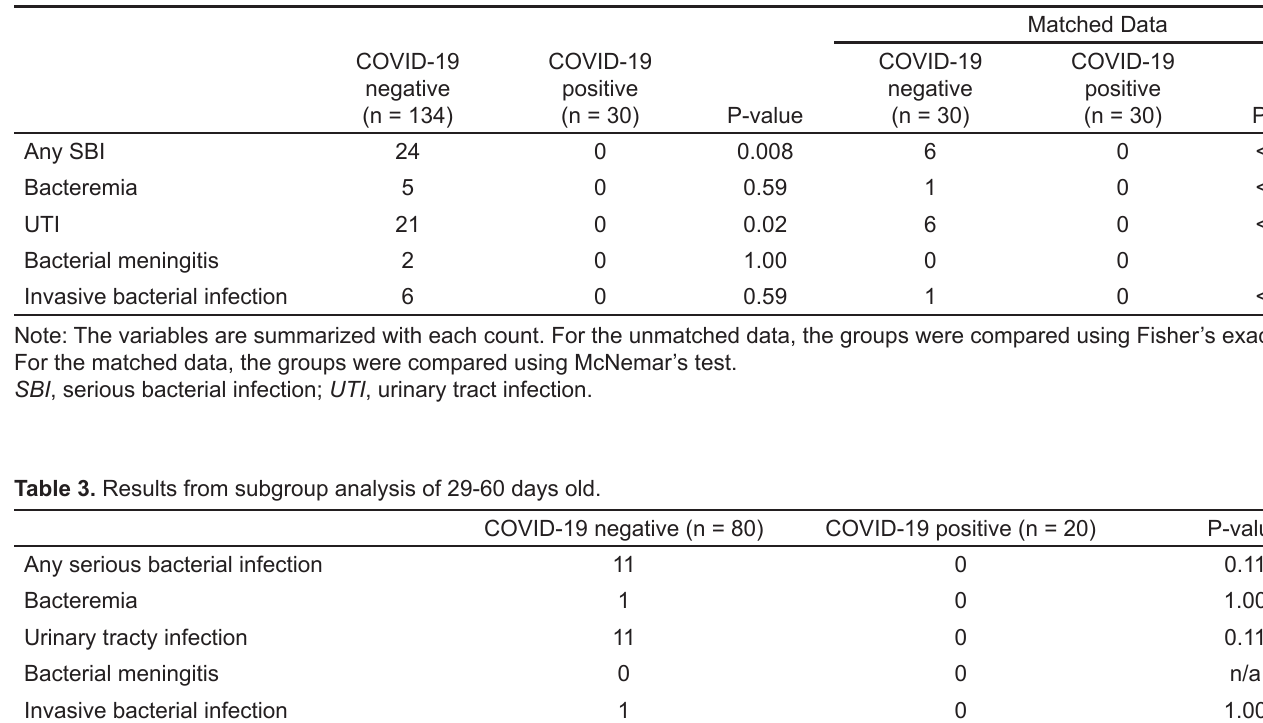
Table 2. Results from unmatched and matched data analyses.